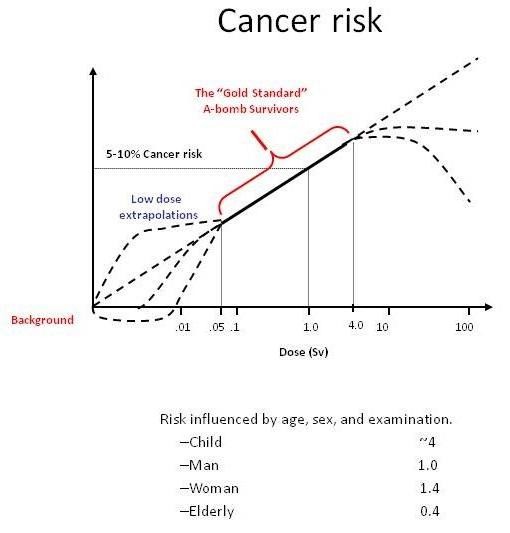
The dose-effect relationship between radiation exposure and cancer. The solid line indicates the epidemiological evidence, which is conclusive for doses above 50 to 100 mSv. The dashed line indicates the dose range with absent or inconclusive evidence.